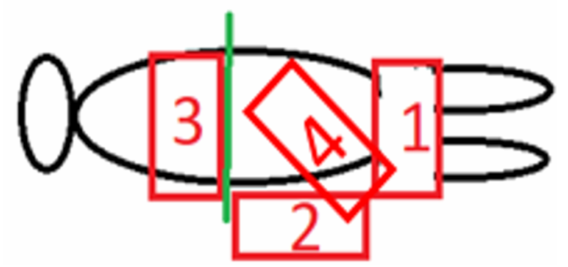
Figure 1. Possible positions for the platform during caesarean